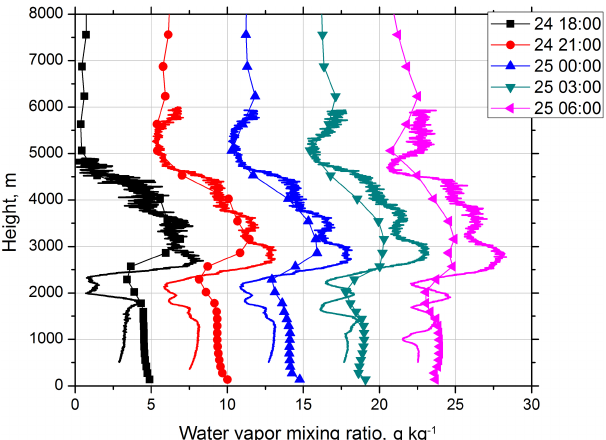
Figure 17. Water vapor mixing ratio derived from Raman lidar mea- surements (solid line) and obtained from the model (line + symbols) on the night of 24–25 December 2015. Temporal intervals are the same as in Fig. 13. The profiles are shifted relatively each other by 5gkg − 1